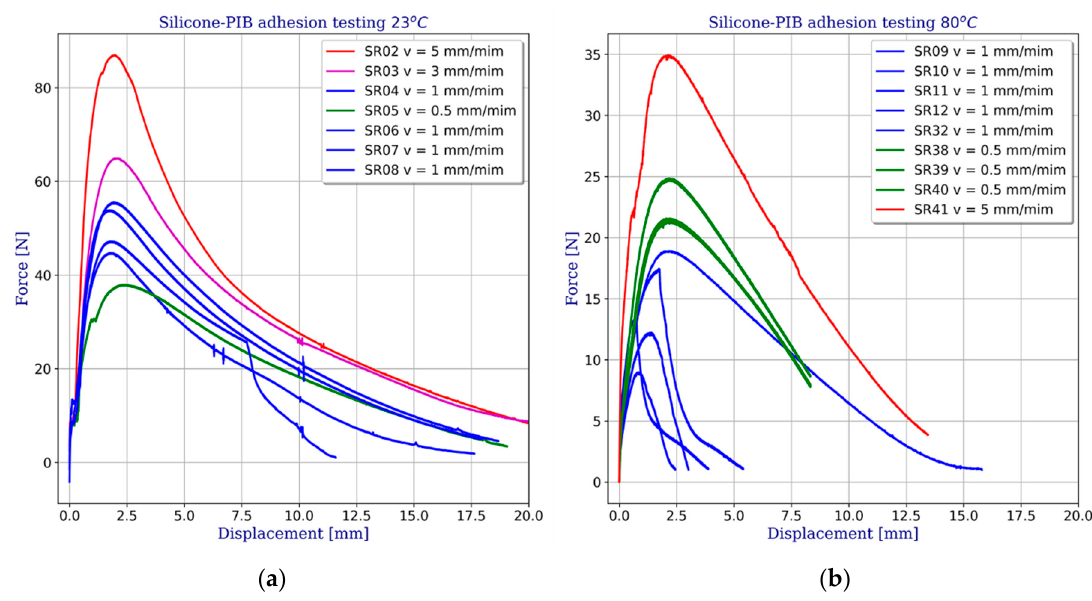
Figure 10. Force-displacement results obtained on silicone-butyl specimens: ( a ) at 23 °C, ( b ) at 80 °C.